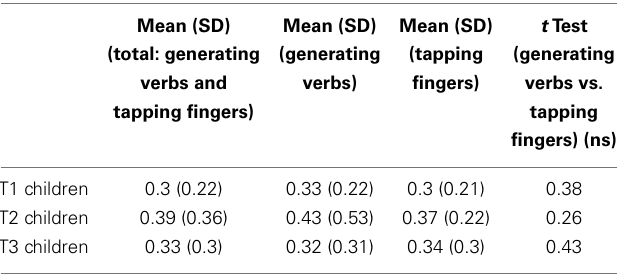
Table 3 | Motion measures, mean, and standard deviation (SD) for children atT1,T2, andT3